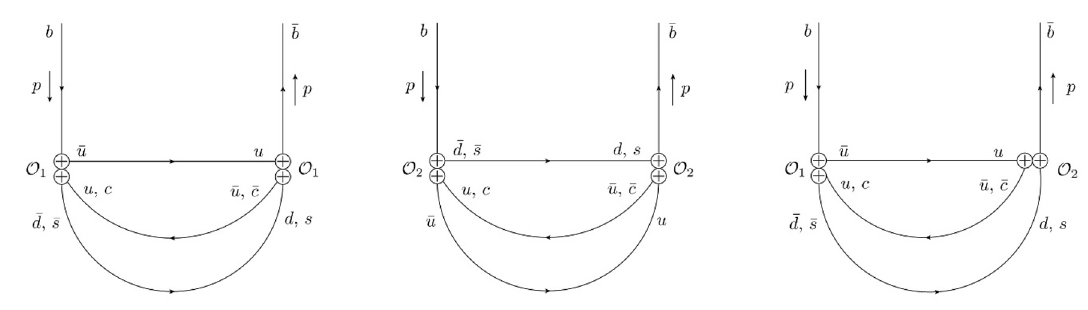
Figure 1 . Two-loop diagrams contributing to the matching coefficients of two-quark operators in the HQE of the B -hadron non-leptonic decay